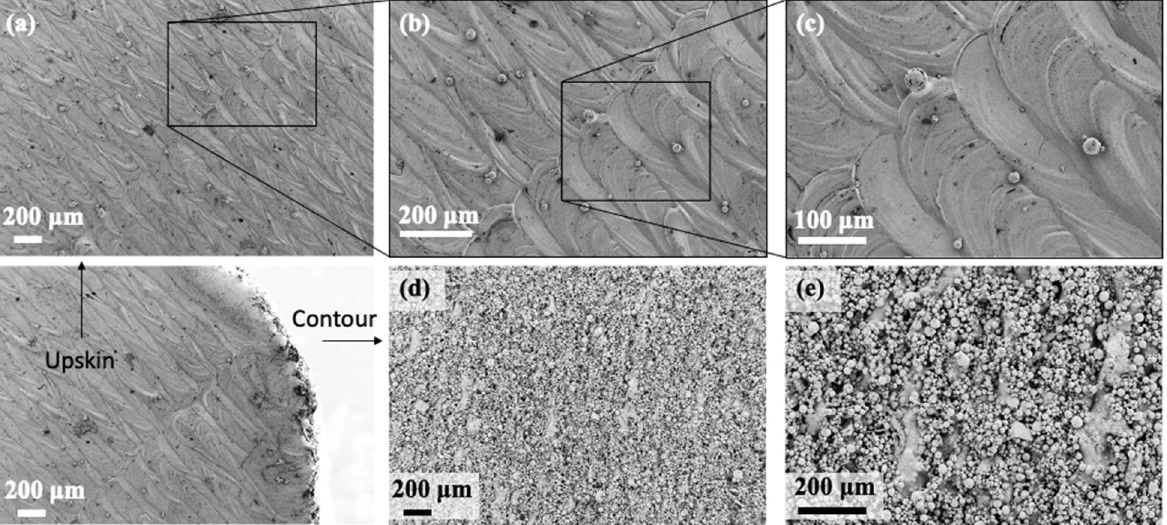
Figure 7. FESEM images of surface roughness of the sample 6 as-built: ( a – c ) on top surface; ( d , e ) lateral surface.